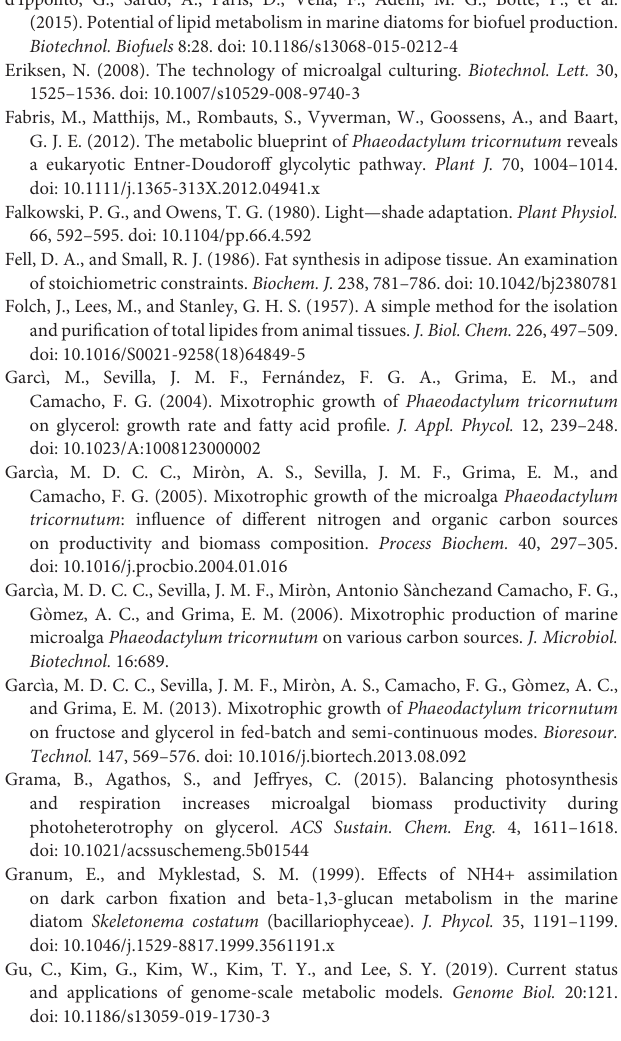
Supplementary File 1 | Calibration curve obtained by the correlation of the absorbance and dry weight. Supplementary File 2 | EE medium composition. Supplementary File 3 | All experimental data and statistical analysis for flask experiments. Supplementary File 4 | All experimental data and statistical analysis for 2-L photobioreactor experiments. Supplementary Figure 1 | Optimization of growth medium in mixotrophic condition. (A) Growth curve (from single experiment) and (B) pictures of flasks in the last day of cultures in the initial medium E10 (black line) in E10+N,P (green line), E10+Fe (yellow line), E10+Me (blue line), and in the optimized medium EE (red line). E10, ESAW 10XN,P; E10+ N,P, ESAW 10XN,P + enriched concentration of N and P; E10+ Fe, ESAW 10XN,P + enriched concentration of Fe;